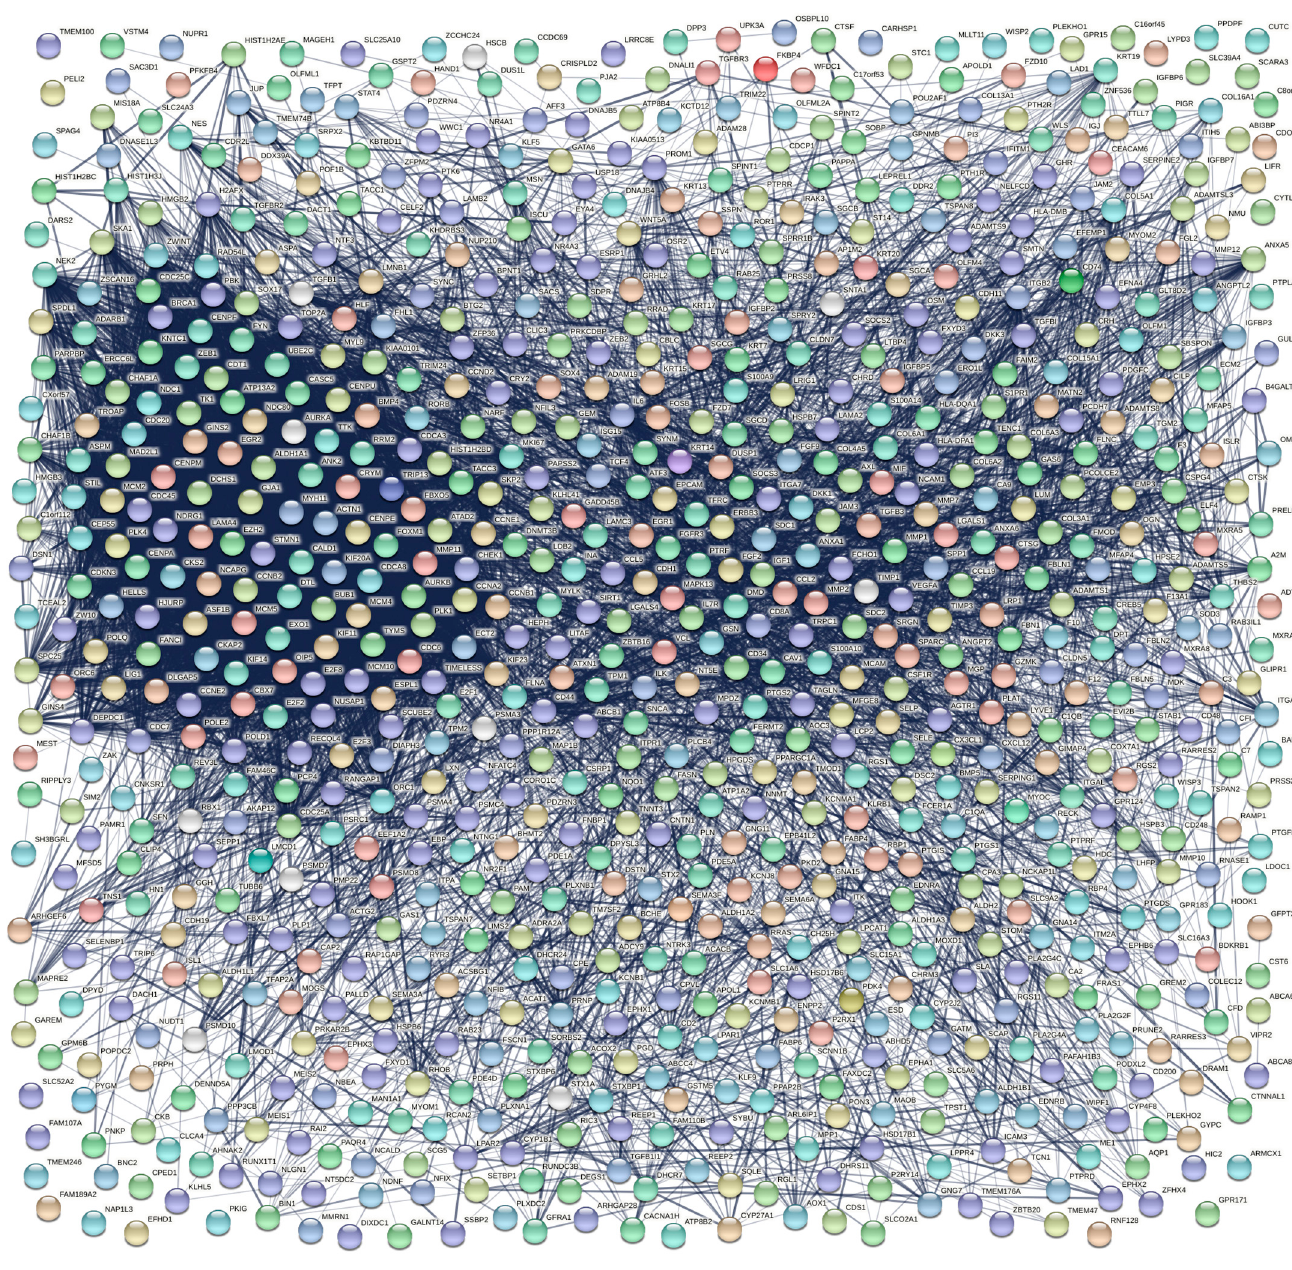
Figure 8. The constructed PPI network visualized by the STRING database. Nodes represent proteins and edges represent protein–protein associations. Line thickness represents the confidence score of a functional